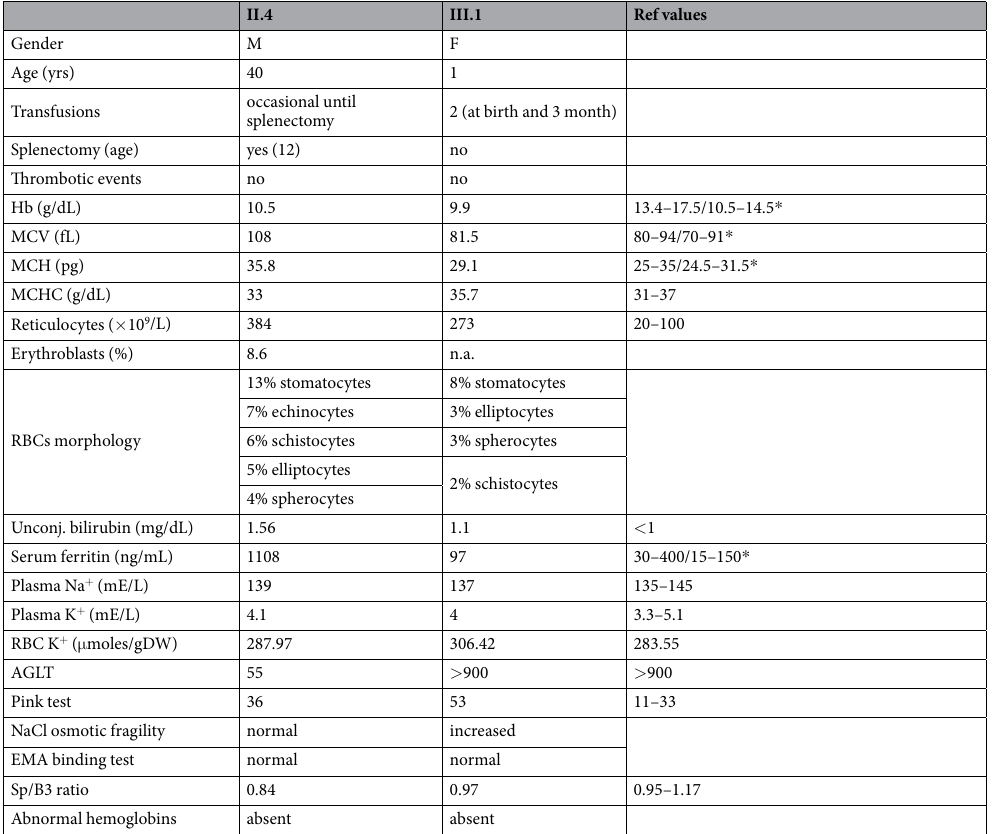
Table 1. Clinical and hematologic data of the patients at the time of the study. n.a. = not available. Sp = spectrin; B3 = band 3. * Age dependent reference